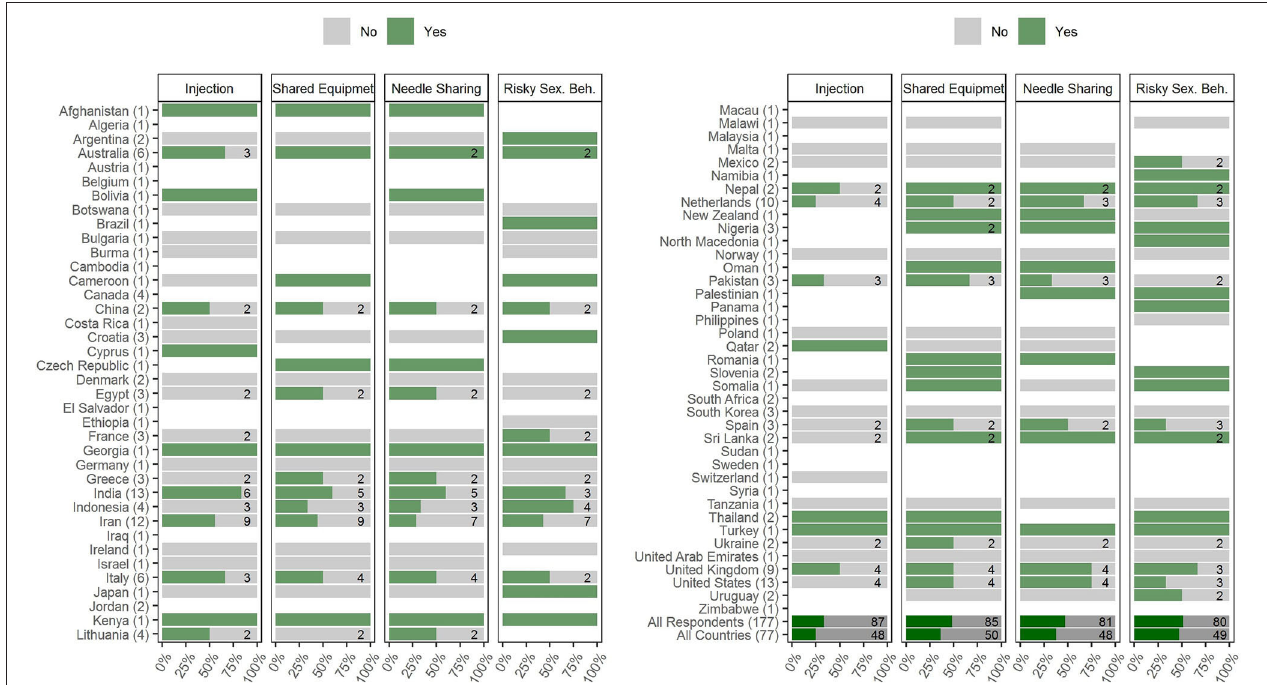
FIGURE 6 | Changes in risky behaviors including shifting to injection, using shared drug use equipment, needle sharing, and risky sexual behaviors during the COVID-19 pandemic period, reported by 177 respondents from 77 countries globally. Respondents were asked to report changes in risky behaviors (injection, shared drug use equipment, needle sharing, and risky sexual behaviors) through the following options: Yes , No , I do not know , I do not like to answer , and Not applicable . Countries’ names are sorted in alphabetical order, and the number of each countries’ respondents is mentioned in front of the names. The numbers of respondents who reported Yes or No answers to each question are demonstrated inside the bars (If nothing is written, it indicates that there was only one response within Yes and No answers). The percentages shown by the bars are also based on only Yes or No answers. The mean percentages of all responses, regardless of their originated countries and without considering those who reported other than Yes and No answers, alongside the mean percentage answers of all countries, regardless of the number of respondents in each country, are addressed in the last two rows below the countries’ names (Risky Sex. Beh., Risky Sexual Behaviors).